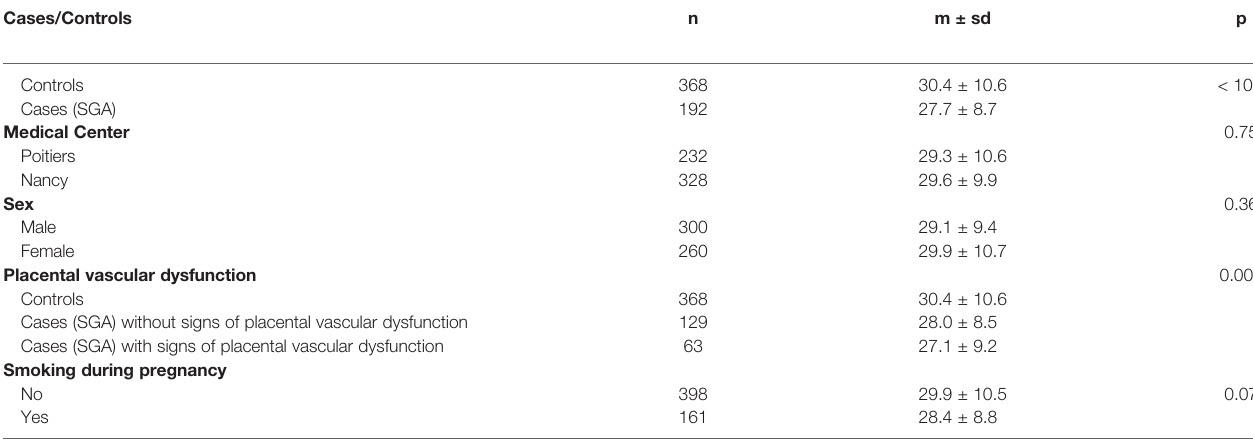
TABLE 2 | DLK1 maternal serum levels at 26 weeks of gestation according to maternal and neonatal characteristics.